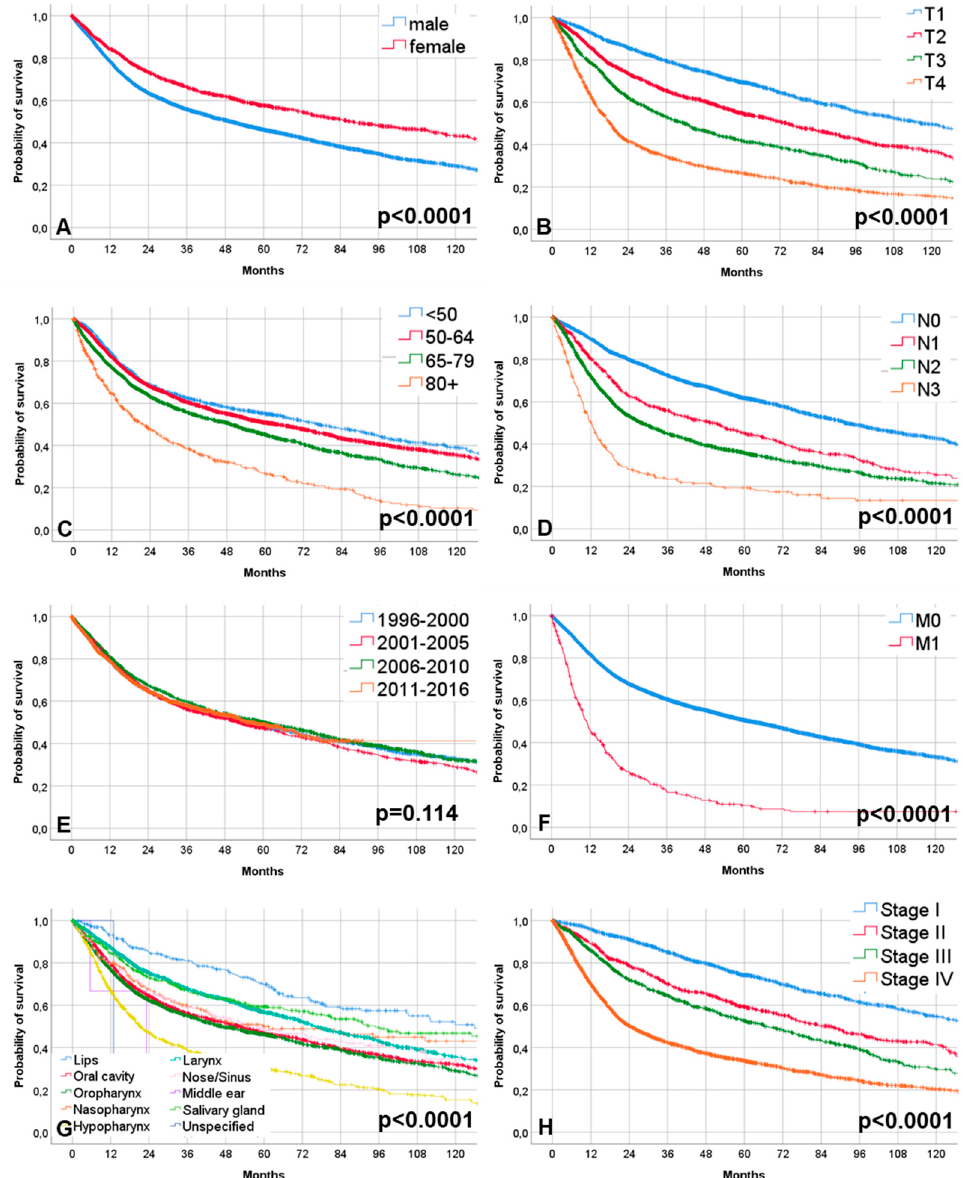
Figure 4. Kaplan–Meier curves of the overall survival. ( A ) Related to gender. ( B ) Related to T classification. ( C ) Related to age groups. ( D ) N classification. ( E ) Related to periods of the year of diagnosis. ( F ) Related to M classification. ( G ) Related to tumor subsite. ( H ) Related to tumor stage.